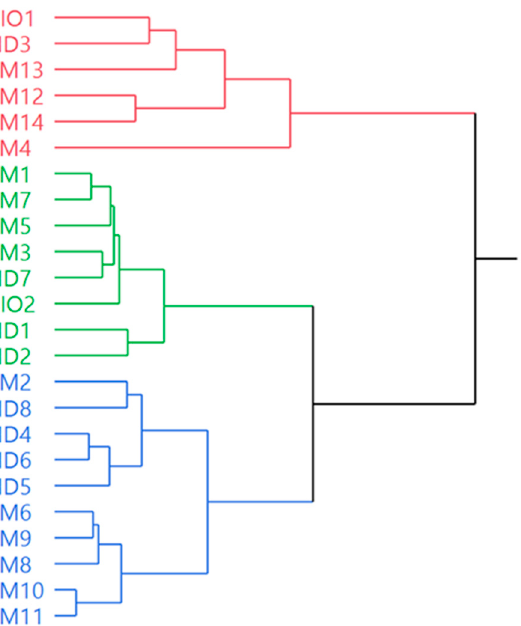
Figure 1. Dendrogram of the hierarchical cluster analysis (HCA) performed on the complete headspace compositions of all bars. Legend for the sample names: organic bars (BIO), supermarket bars (SM), and hard discount bars (HD).